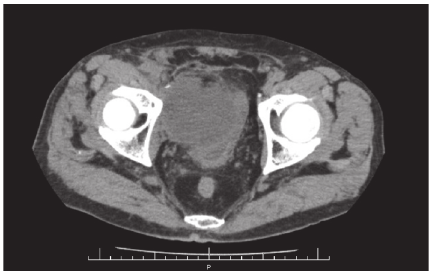
Figure 1: CT scan shows an 80 mm cystic lesion displacing the urinary bladder 6 months after the surgery.